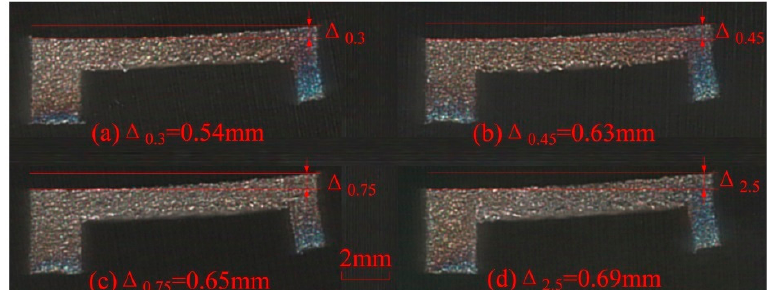
Figure 5. Deformations of specimens with different gaps of ( a ) 0.30 mm; ( b ) 0.45 mm; ( c ) 0.75 mm; and ( d ) 2.5 mm.